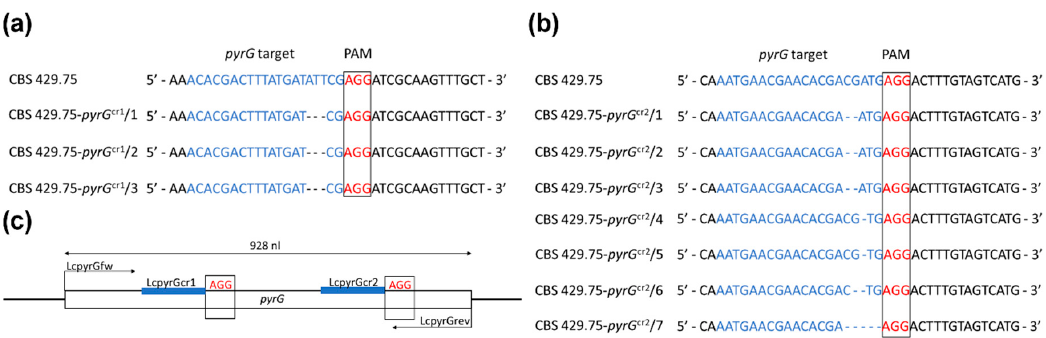
Figure 2. CRISPR-Cas9 induces deletions in the targeted sites of the L. corymbifera pyrG gene. ( a ) Sequence of the site in the pyrG gene targeted using the LcpyrGcr1 protospacer and location of the induced mutations in the three resulting strains. ( b ) Sequence of the site in the pyrG gene targeted using the LcpyrGcr2 protospacer and location of the induced mutations in the seven resulting strains. The protospacer and the protospacer adjacent motif (PAM) sequence are highlighted with blue and red letters, respectively. ( c ) Diagram representing the pyrG gene and showing the positions of the targeted sites and the primers used to analyze the